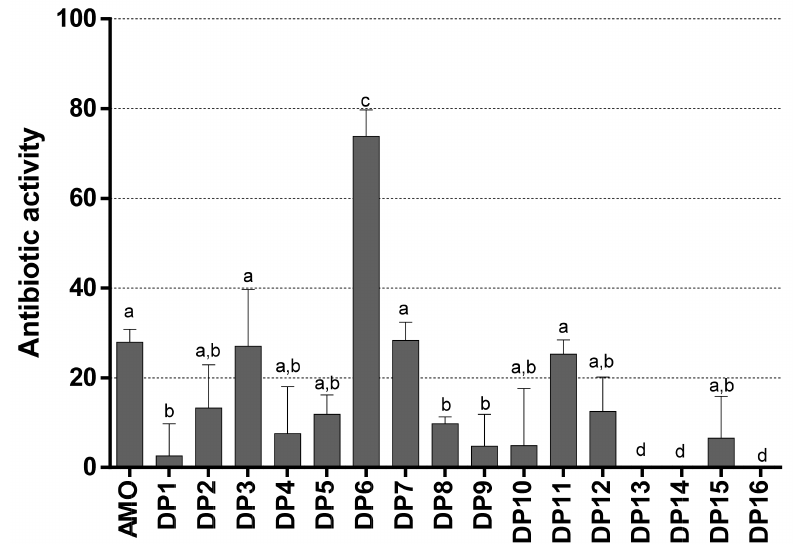
Figure 5. Antibacterial activity of AMO and its DPs against S. aureus . Groups with the same letter were not significantly different (Tukey post hoc, p <